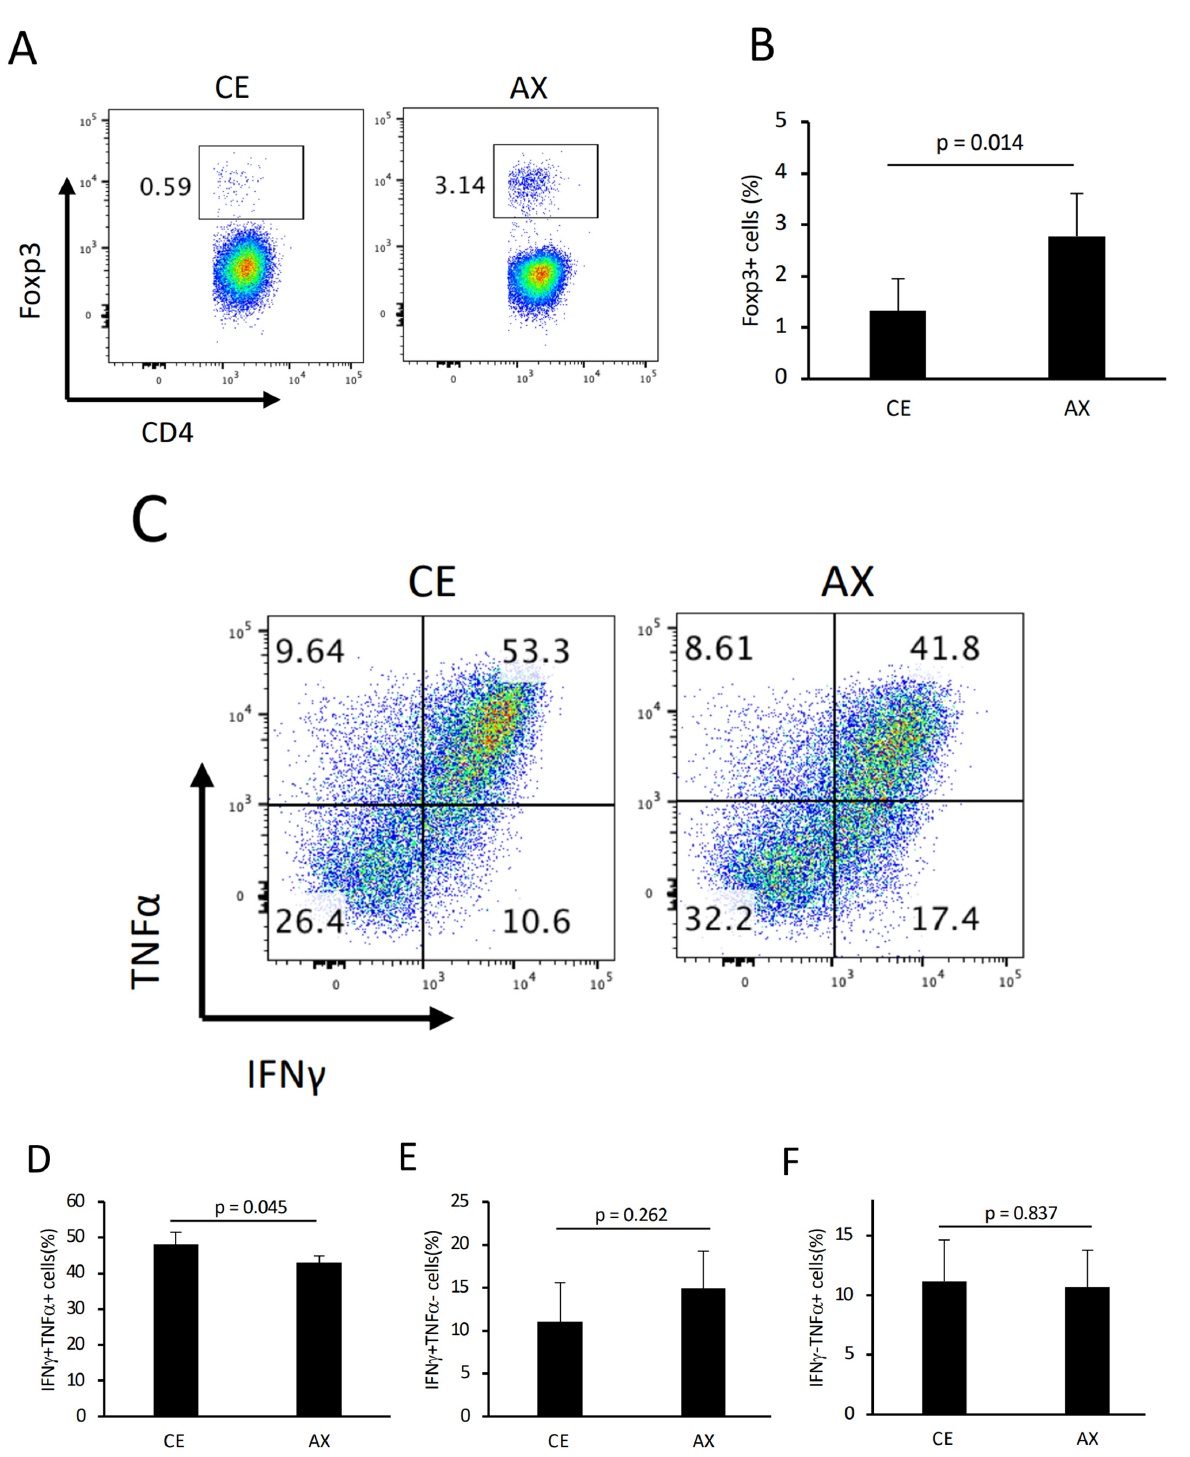
Figure 6. The effect of AX on colonic T cells in colitis model mice: ( A ) Typical FACS panel showing the percentage of Foxp3 + T cells 6 weeks after the adoptive transfer of naïve CD4 + T cells in the Rag1 − / − mice. ( B ) Percentage of Foxp3 + T cells gated on CD4+. ( C ) Typical FACS panel showing the IFN γ − and/or TNF α -producing CD4+ T cells. ( D – F ). The percentage of IFN γ + /TNF α + , IFN γ + /TNF α − , and IFN γ − /TNF α + T cells gated on CD4+. Values and error bars indicate the mean ±